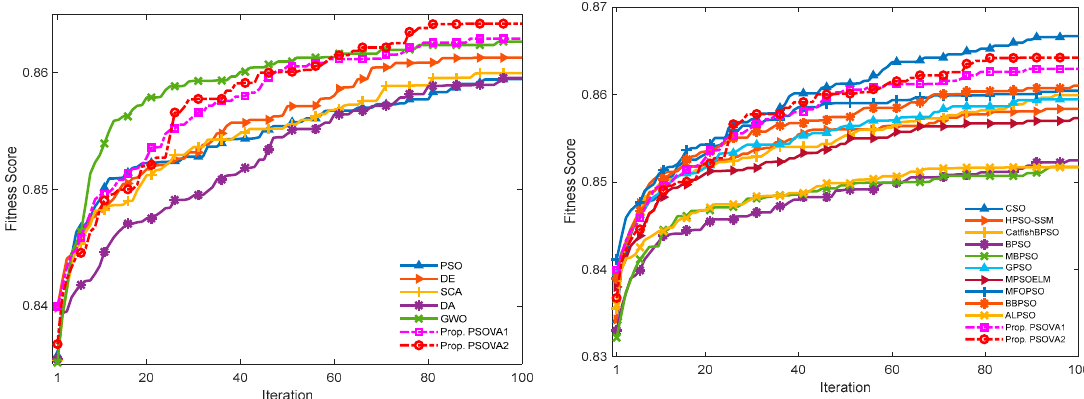
Figure 5. Mean convergence curves over 30 runs for the classical search methods ( left ) and advanced PSO variants ( right ) for the Crohn’s disease data set (where x and y axes denote the iteration number and the fitness score, respectively.).